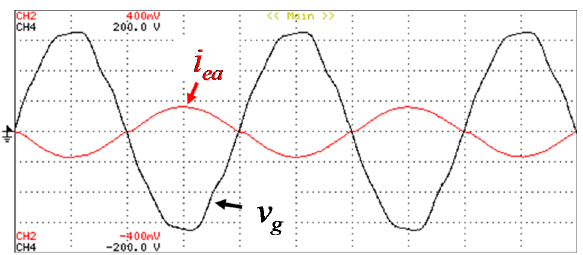
Figure 10. Experimental results during the MF-EVCS operation in V2G mode: Ac-side voltage ( v g : 50 V/div) and ac-side current ( i evcs : 10 A/div). Energies 2020 , 13 , 1864